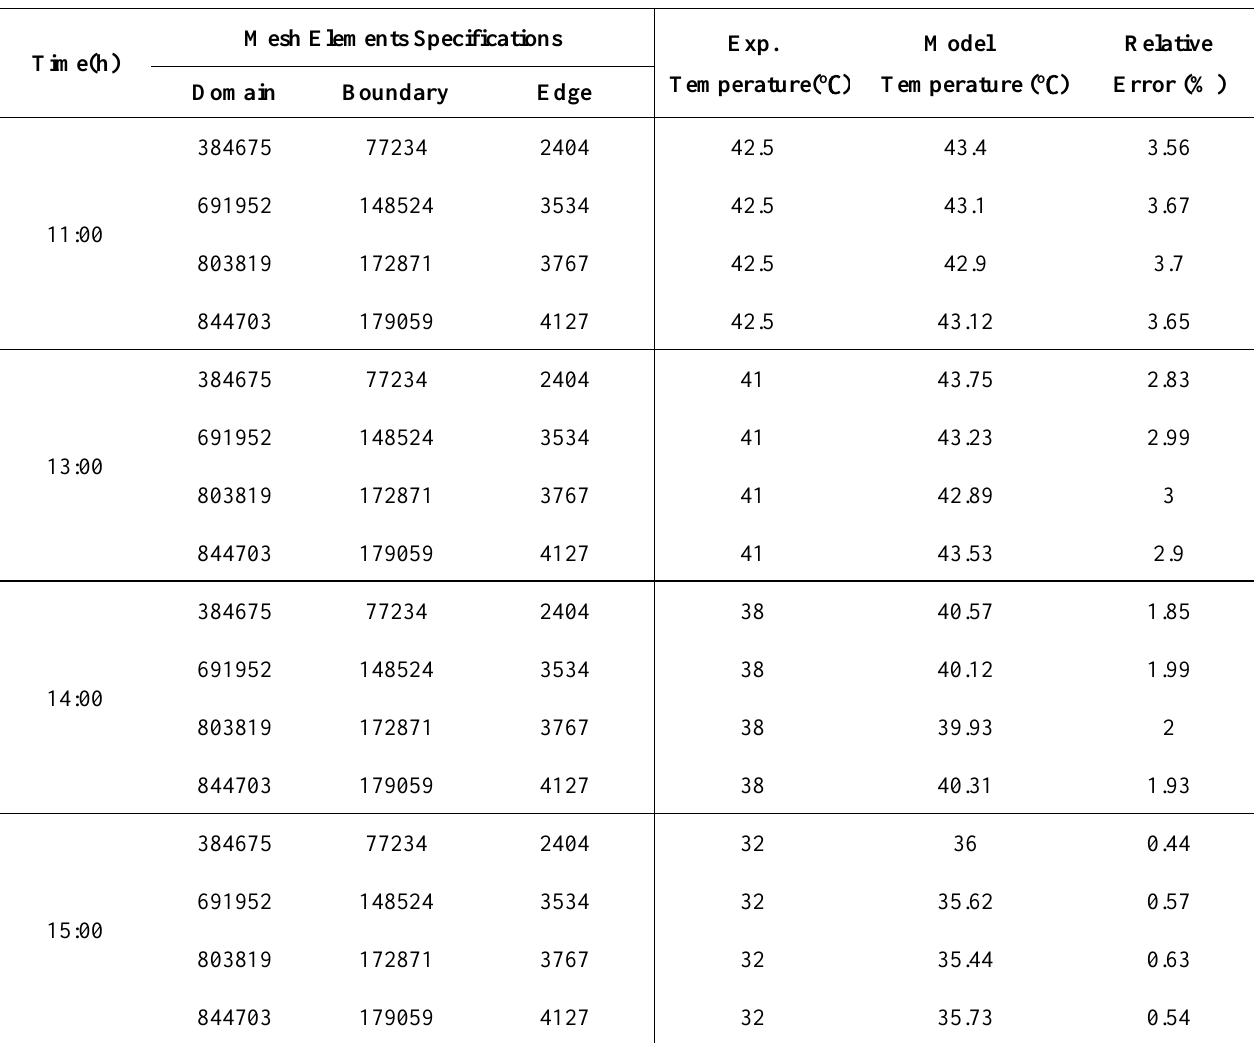
Table 2. Mesh Independence